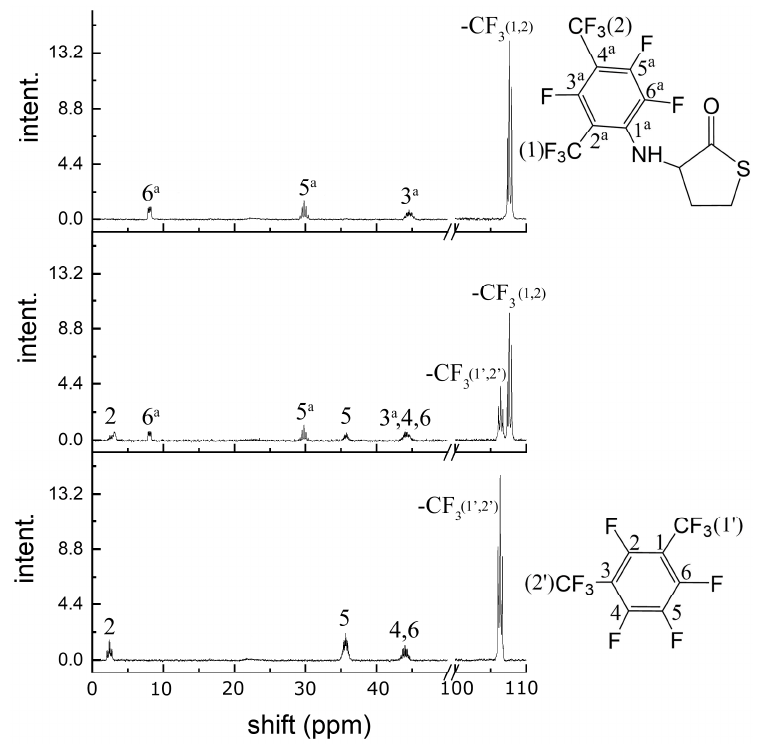
Figure 5. Typical 19 F NMR spectra for PFX and HTL reaction in DMSO at 0 ( bottom ), 40 ( center ), and 163 ( top ) min. The reagent ratio PFX:HTL:NEt 3 equals to 1:1.25:1.65.